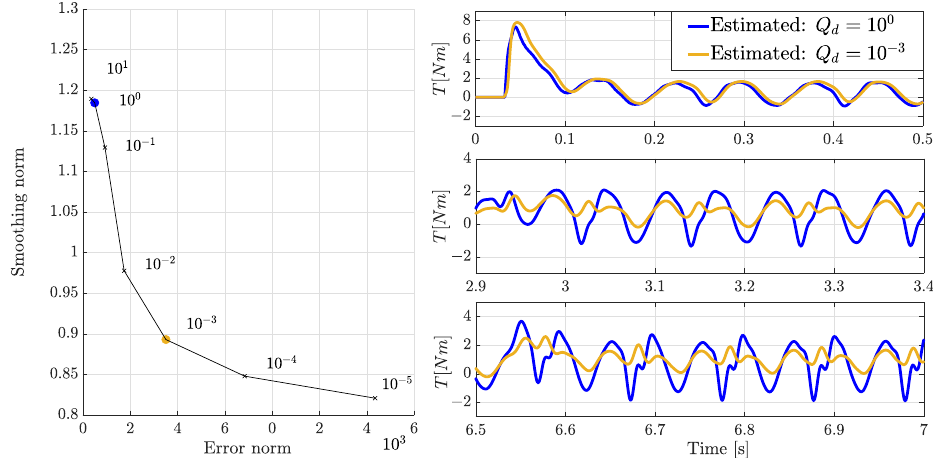
Figure 9. The L-curve plot for different process variance Q d ( left figure ) and zoom-in comparison on the velocity transition of the measured and estimated motor torque using two different values of process variance Q d ( right figure ).